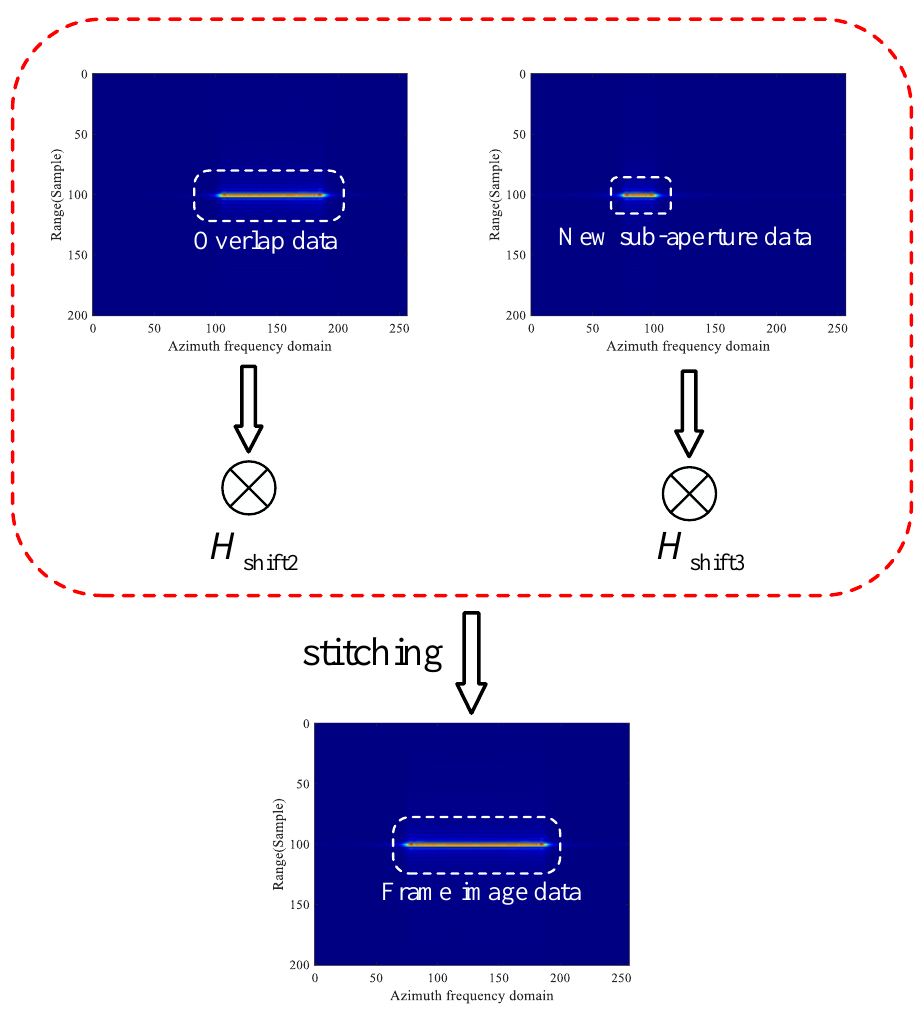
Figure 7. Schematic diagram of sub-aperture data stitching. The flowchart of sub-aperture data processing is shown in Figure 8. Considering the complex scenarios, the focusing algorithm in step 1 needs to be improved to ensure that the sub-aperture data is